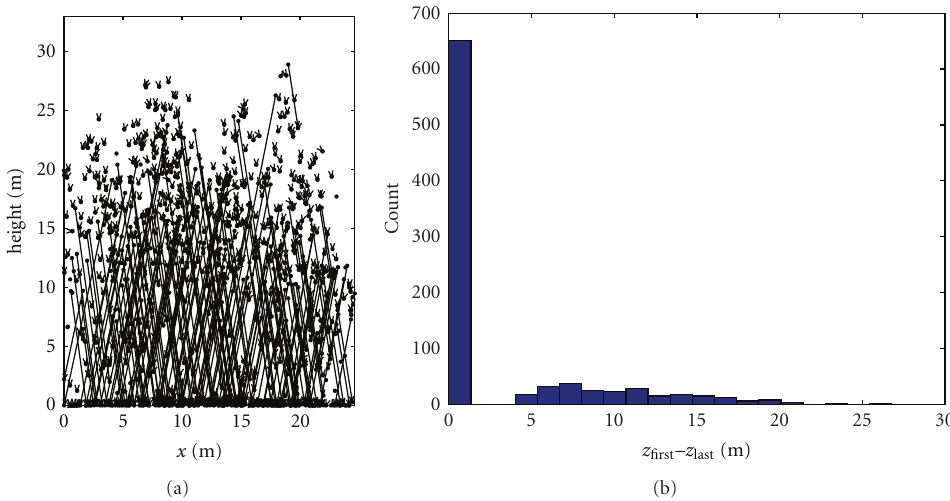
Figure 4: (a) LiDAR point cloud in one field plot with the first and last returns linked by arrow-headed lines, and (b) the histogram of the elevation di ff erences between first and last returns for the same